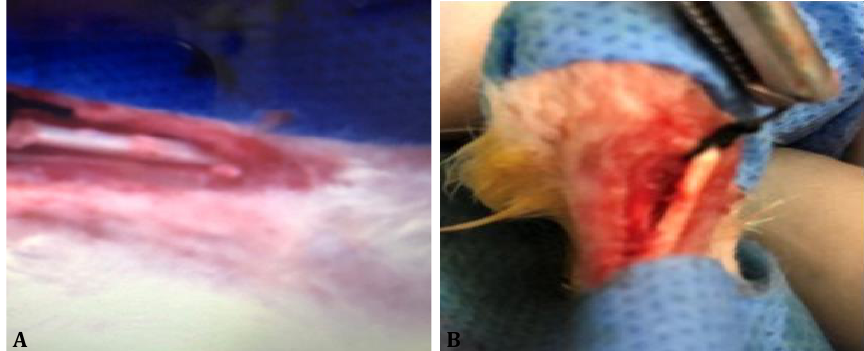
Figure 2. Representative photographs of injured area in the local rabbit (A) Control group on 15th postoperative day tendon edema, adhesion, white substance (suspected to be fibrin) covers injured area, (B) 25-min diode impulse laser irradiated group on 15th postoperative day showing good healing with no adhesions